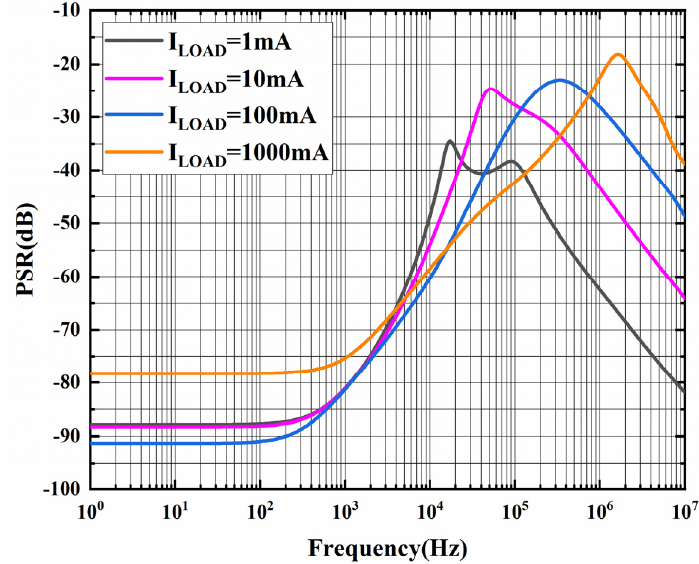
Figure 9. Simulated PSR of the LDO at different load conditions.